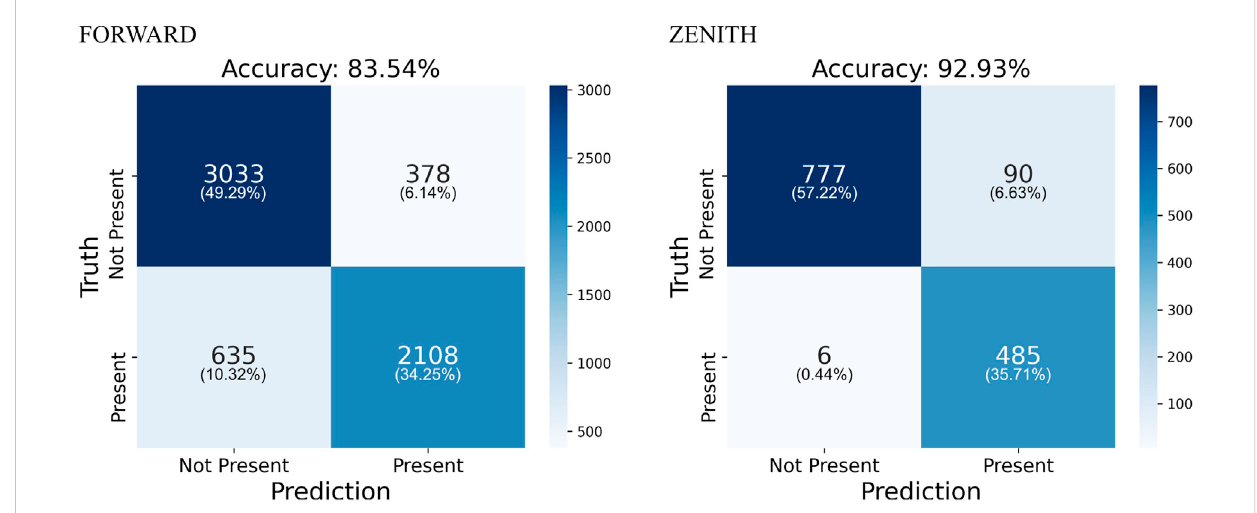
FIGURE 6 CDNN – SPN-Sconfusion matrices. Binary confusion matrices werecreatedby comparing forward CDNNand zenith CDNNcloud masks with SPN- Scloudmasks.The “ Truth ” binaryvaluesindicate theSPN-Scloud mask,whereasthe “ Predictions ” indicate theCDNNcloudmask predictions. The fi gure shows the accuracy of the forward and zenith CDNNs against the SPN-S cloud masks that we generate, and where the error is based on false positive or negative